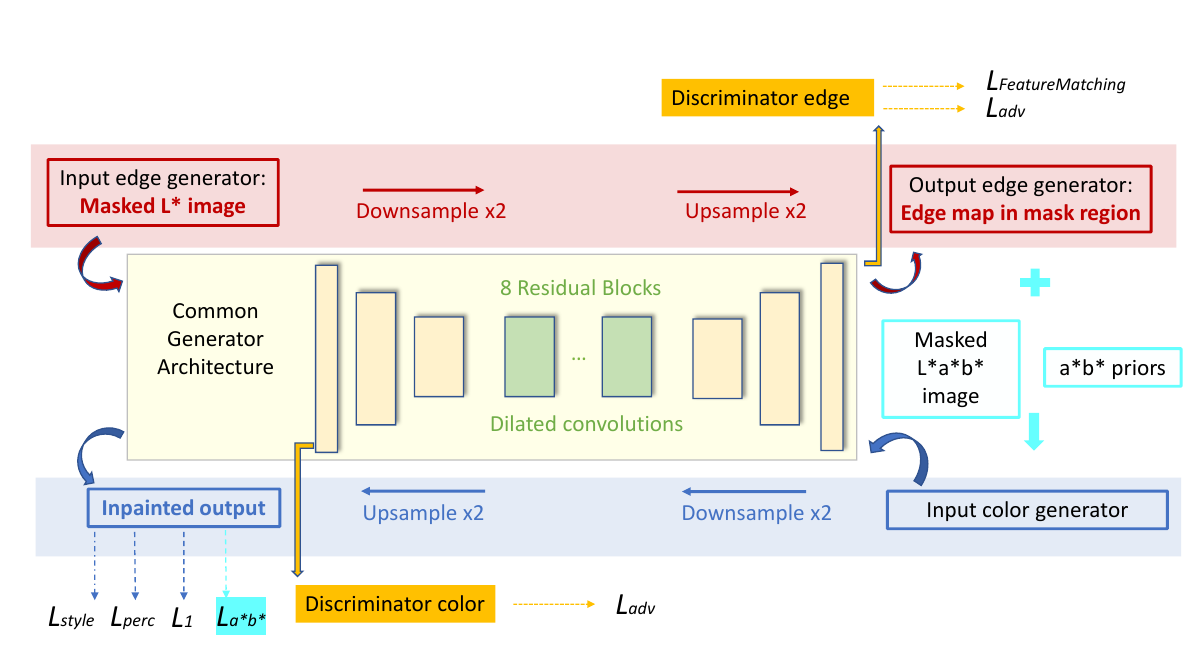
Figure 3. Both color and edge generators have the same underlying convolutional architecture, composed of encoder– decoder blocks and eight residual blocks with dilated convolution in between. Different from [17], we introduce the L a ∗ b ∗ loss for the color generator to lower the bias towards mean values of the dataset’s